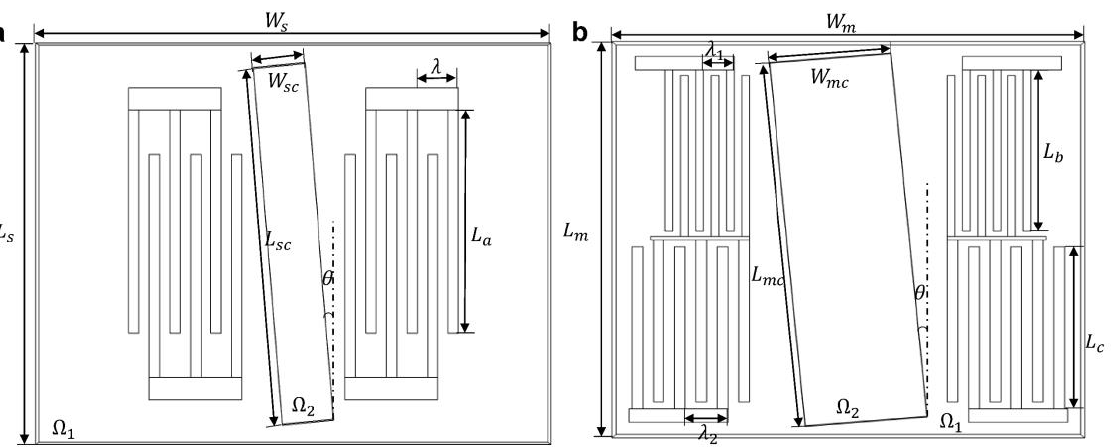
Table 1. Model parameters.